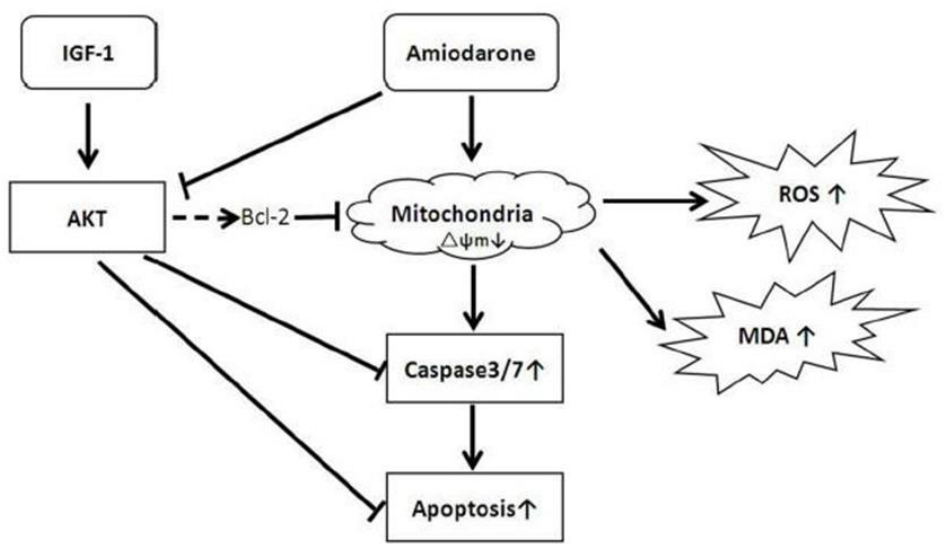
Figure 4. A proposed mechanism of IGF-1 mediated attenuation of amiodarone toxicity in the RPE. Amiodarone inhibits the activity of Akt and decreases mitochondrial membrane potential stability ( ∆ ψ m). This membrane instability in turn results in increased ROS production, MDA lipid peroxidation, and caspase 3/7 driven apoptosis. IGF-1 stimulates the activity of Akt, thereby reducing oxidative and proapoptotic mechanisms of cell death from amiodarone [37].